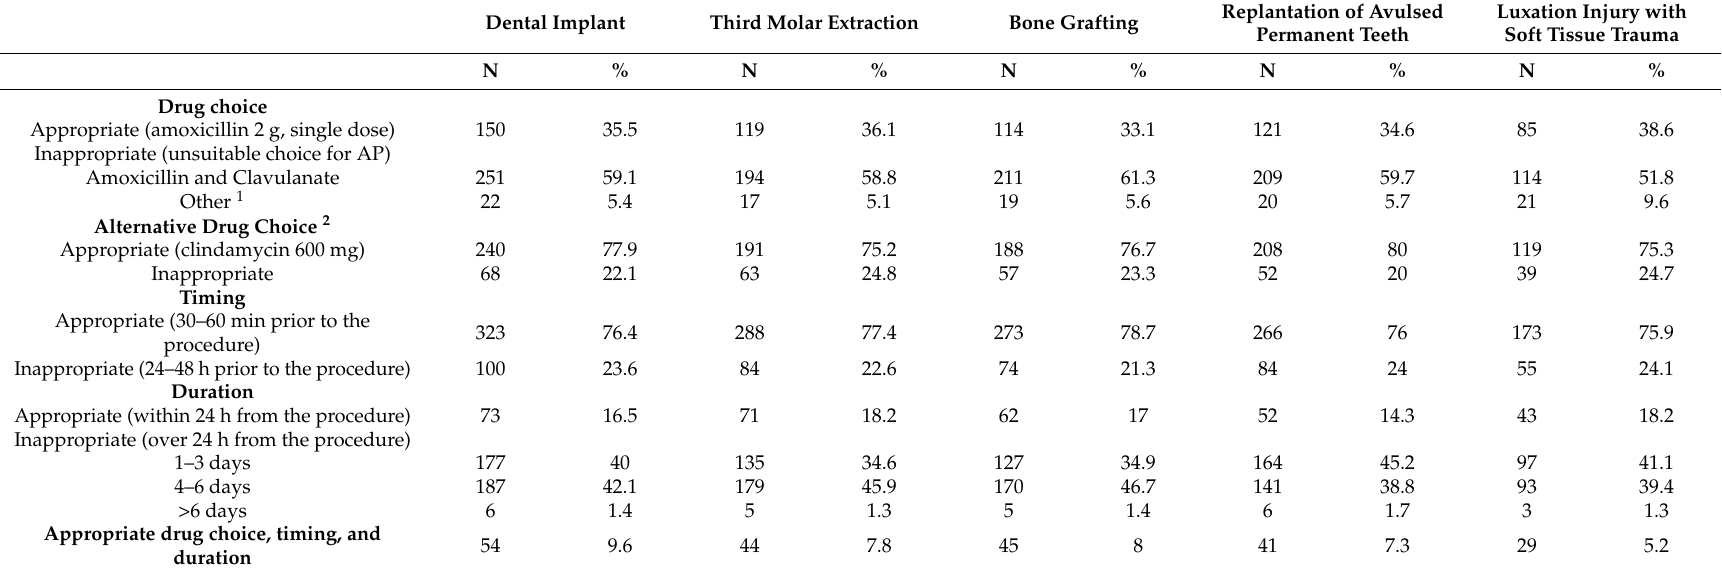
Table 2. AP prescription approach in procedures with indication, according to drug choice, timing, and duration. Dental Implant Third Molar Extraction Bone Grafting